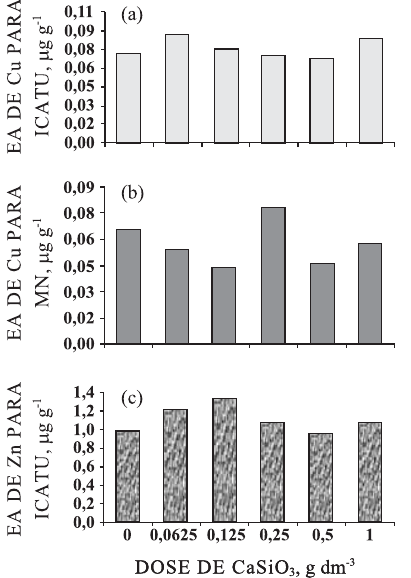
Figura 2. Eficiência de absorção (EA) de cobre pelas variedades Icatu (a), Mundo Novo (b) e de zinco para a variedade Icatu (c), em função das doses de silicato de cálcio (CaSiO substrato de plantio.